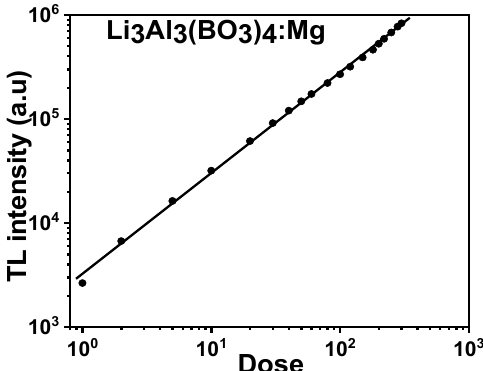
Figure 14. Dose linear–response for Mg-doped lithium aluminium borate.